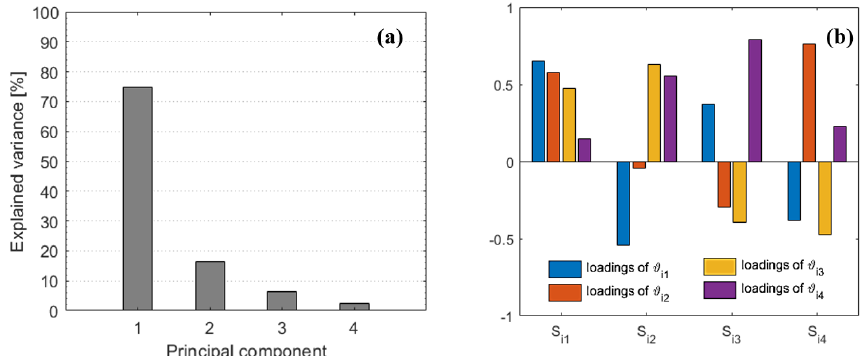
Figure 5. (a) Total variance explained by each principal component; (b) estimated loadings for each principal component S i .